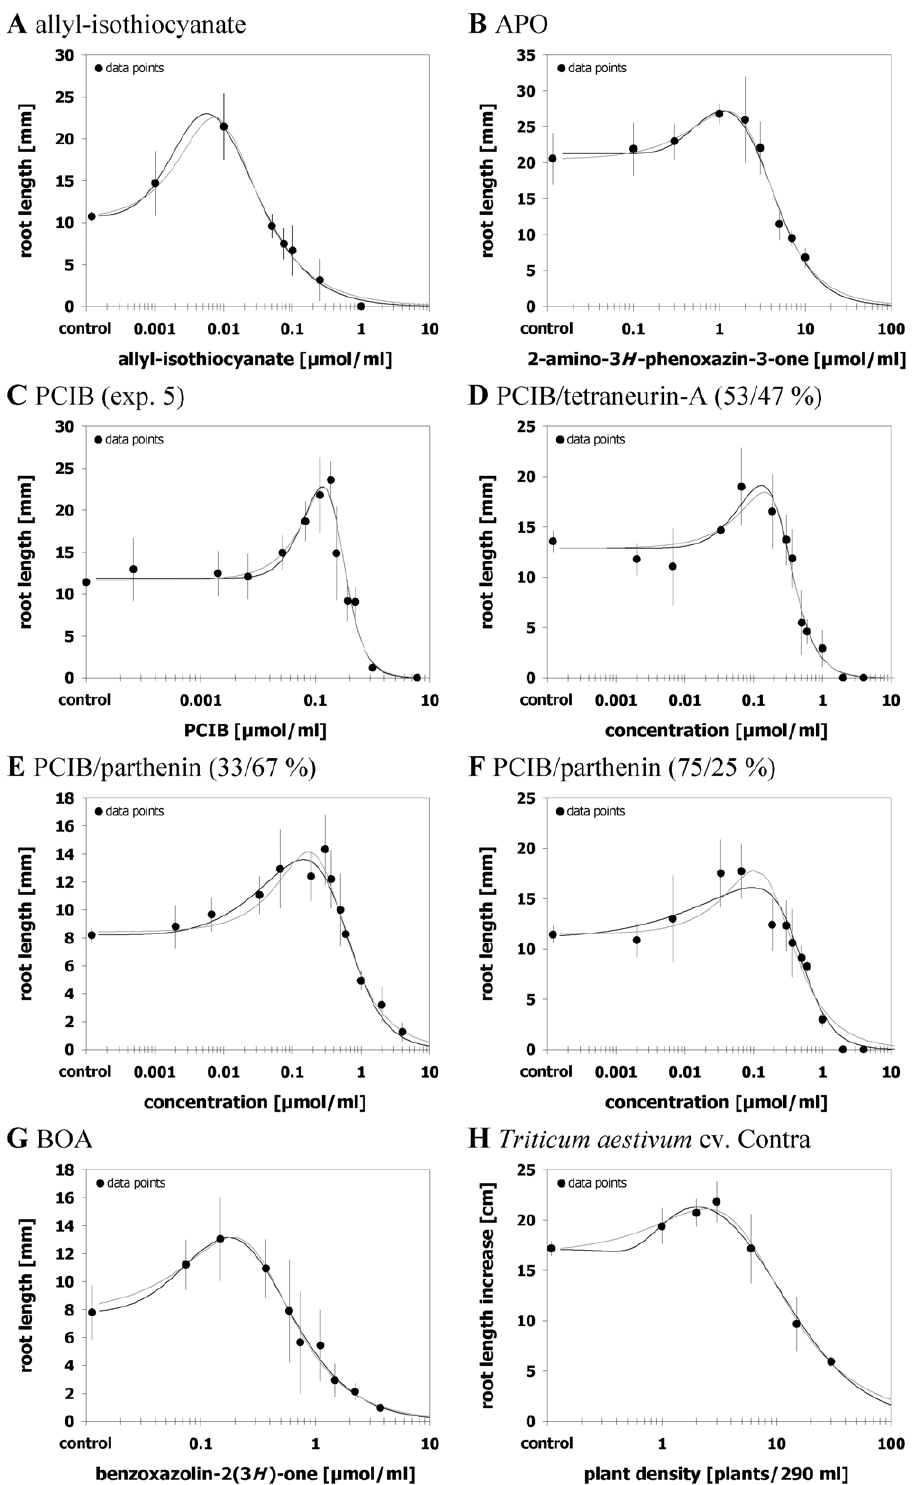
Figure 4. Both logistic hormetic models equally suitable. Dose-response relationships for effects of different phytotoxins on root growth of Amaranthus hybridus (A), Lactuca sativa (B–F), or Medicago sativa (G) and for effects of root exudates of Triticum aestivum on root growth of Sinapis alba (H) and their description by the hormetic dose-response models after Brain and Cousens [9] (grey curve) or Cedergreen et al. [2] (black curve). Both models provided an adequate, marginally varying fit. Error bars represent standard deviation.